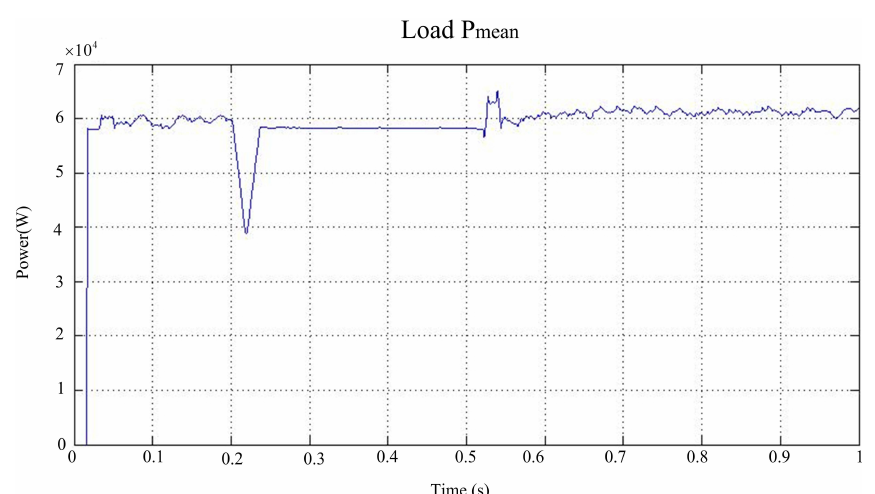
Figure 11. The total load power.